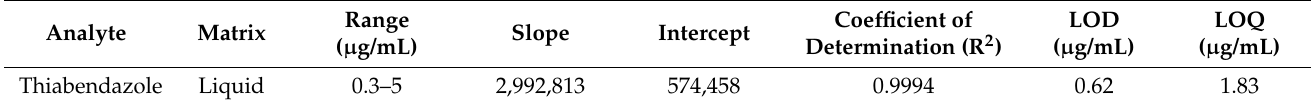
Table 5. Coefficient of determination (R 2 ) of the calibration curves, limit of detection (LOD), and limit of quantification (LOQ) for the analytical method for thiabendazole in the liquid food samples using